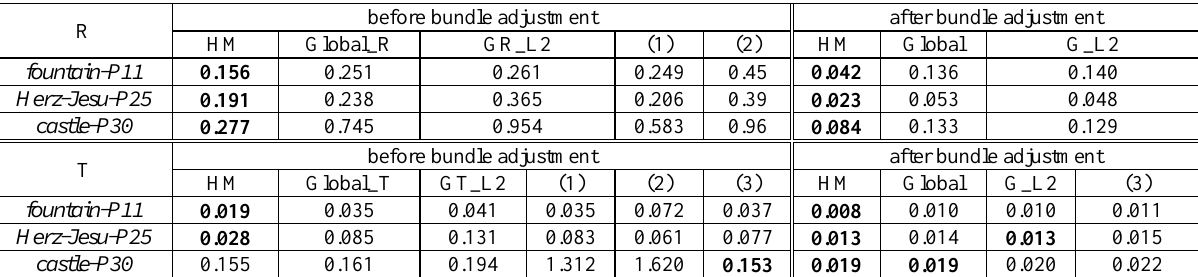
Table 2. Mean angle error R in degree and mean translation error T in meter for different global estimation methods. We compared our